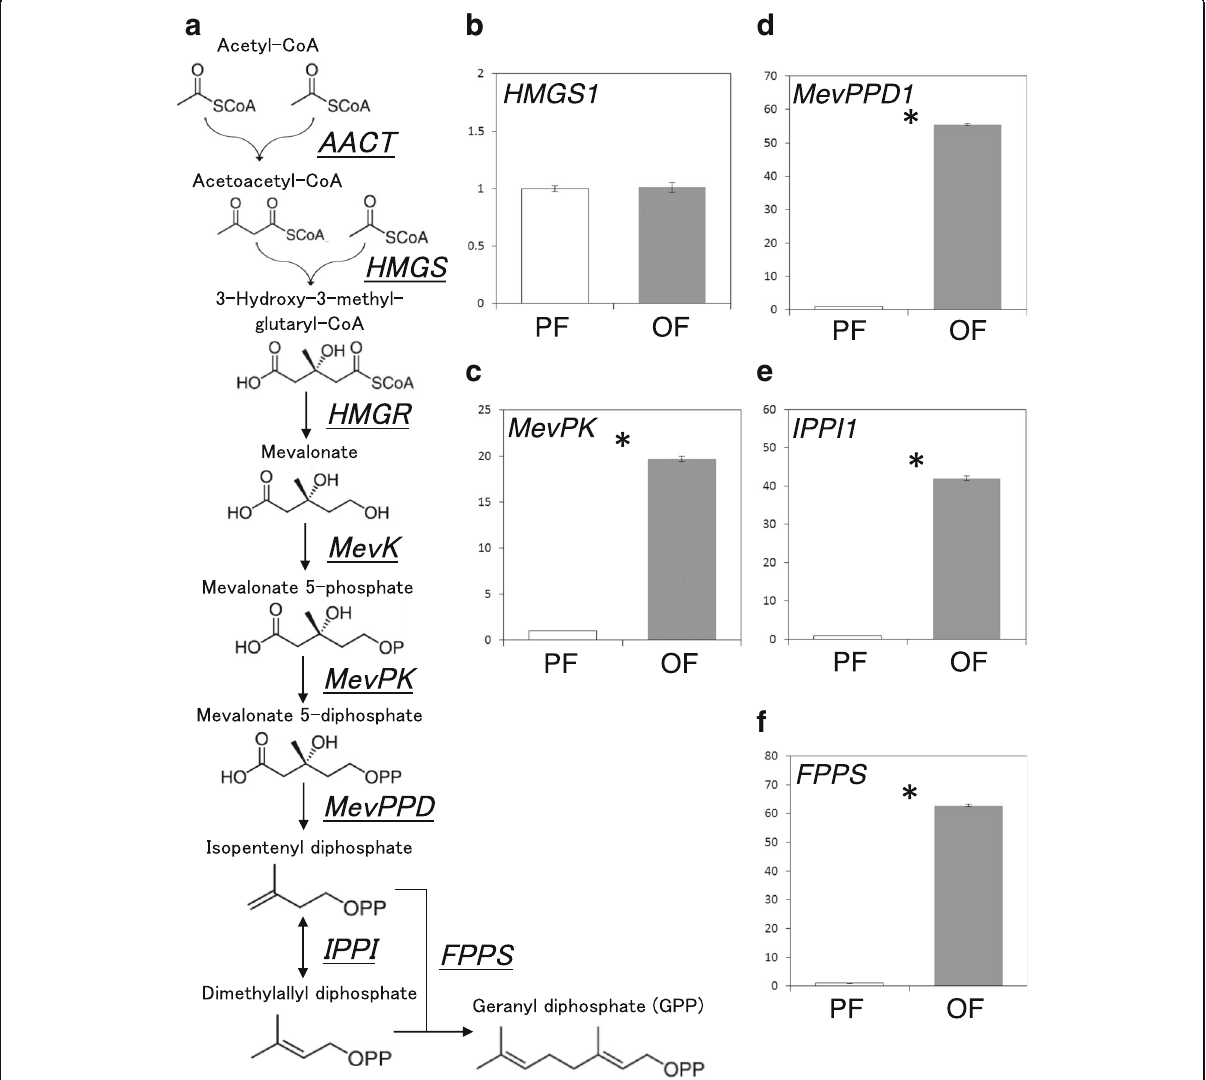
Fig. 5 Comparisons of relative expression levels of enzyme genes in hind tibias. a: The mevalonate pathway with responsible catalytic enzymes. b – f : Expression levels of genes coding the mevalonate pathway enzymes. b : HMG-CoA synthetase (3-hydroxy-3-methylglutaryl-coenzyme A synthase, HMGS1 ), c : phosphomevalonate kinase ( MevPK ), d : mevalonate 5-diphosphate decarboxylase ( MevPPD1 ), e : isopentenyl pyrophosphate isomelase ( IPPI1 ), f : farnesyl diphosphate synthetase ( FPPS ). Blank and gray bars indicate parthenogenetic (PF) and oviparous females